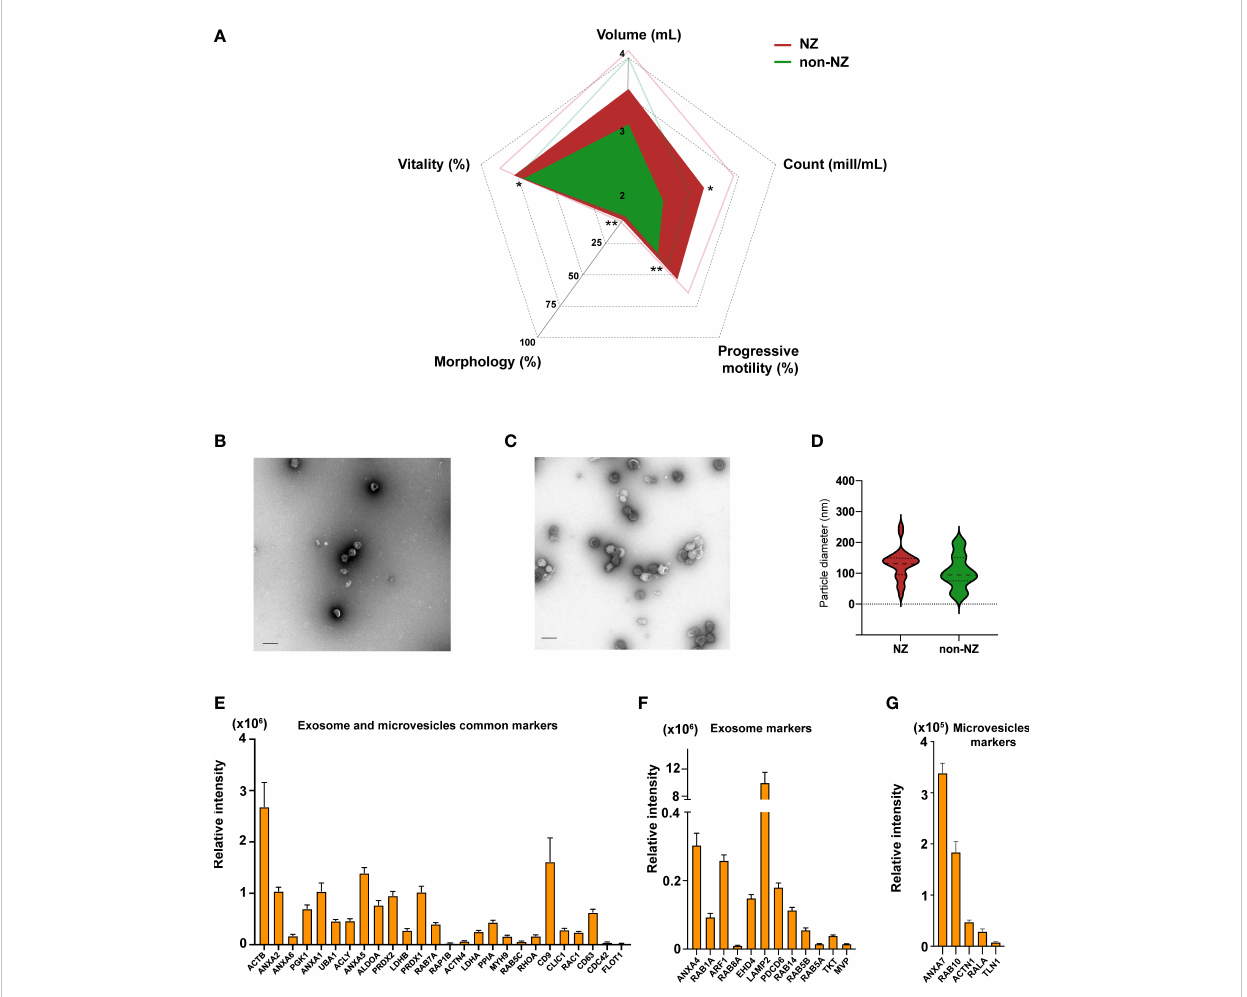
FIGURE 1 Analyses of clinical sperm parameters in normozoospermic (NZ) and non-normozoospermic (non-NZ) men and physicochemical characterization of sEVs. (A) Spider web chart displaying the average sperm parameters of NZ and non-NZ subjects. Thin lines represent the standard deviation. Signi fi cant differences between groups were assessed by Student ’ s t -test (signi fi cance established at p ≤ 0.05), and sperm progressive motility was the most signi fi cantly affected clinical sign of non-NZ men followed by count and vitality, and morphology. Ultrastructural characterization of sEVs from (B) non-NZ men and (C) NZ men. (D) Violin graph depicting vesicle size quanti fi cation from the obtained micrographs of sEVs of non-NZ men and NZ. No statistically signi fi cant differences in particle size were observed between the analyzed groups ( p < 0.05). (E) Bar chart indicating the average relative intensity detected by LC-MS/MS of EV markers commonly curated in the specialized databases Exocarta and Vesiclepedia identi fi ed in sEVs. (F) Bar chart indicating the average relative intensity detected by LC-MS/MS of speci fi c exosome markers curated in the specialized database Exocarta identi fi ed in sEVs. (G) Bar chart indicating the average relative intensity detected by LC-MS/MS of speci fi c microvesicle markers curated in the specialized database Vesiclepedia identi fi ed in sEVs. * p ≤ 0.05 and ** p < 0.01 — levels of signi fi cant differences. Scale bars in transfer electron microscopy micrographs represent 200